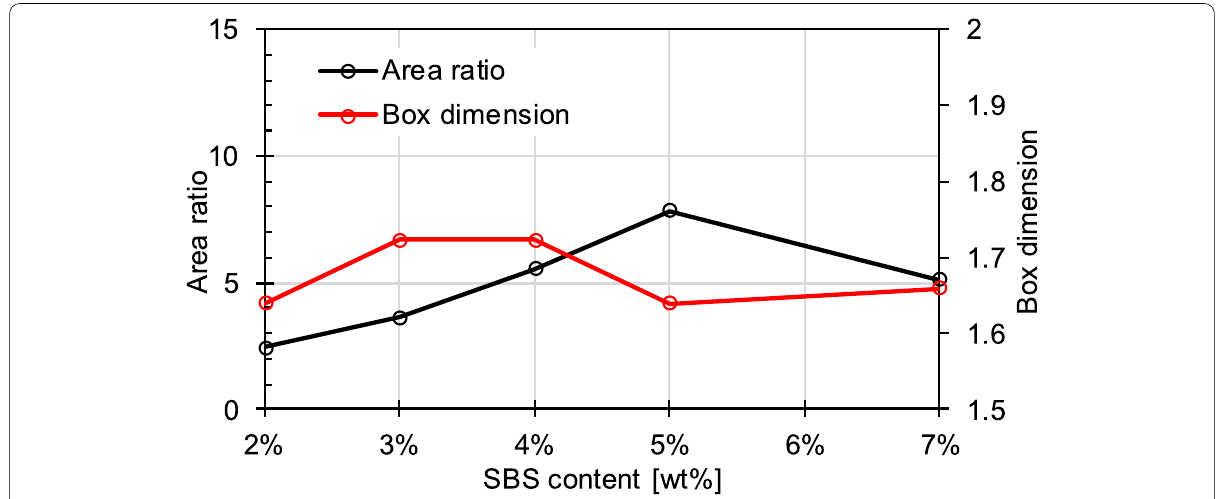
Fig. 6 Influence of SBS content on the area ratio and box dimension in